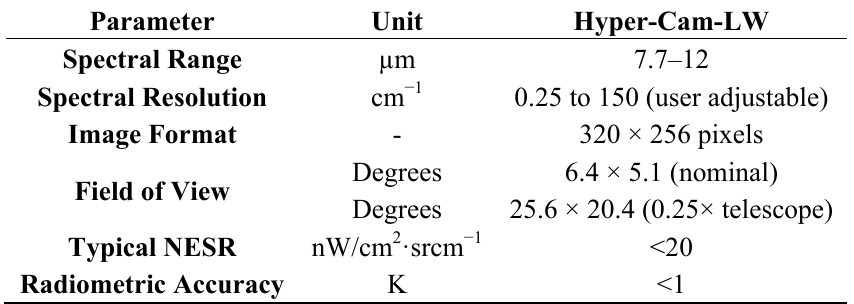
Table 1. Hyper-Cam-LW specifications; NESR = noise equivalent spectral radiance.